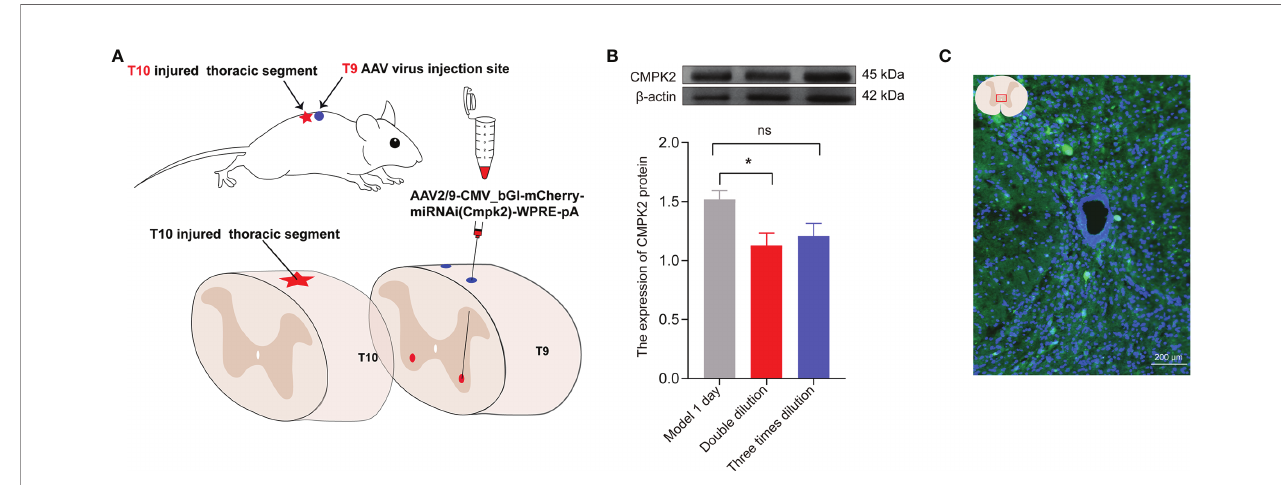
FIGURE 7 | The expression of CMPK2 around the central canal of the spinal cord was decreased after CMPK2 knockdown. (A) Schematic diagram of virus injection. (B) Quantitation of CMPK2 in the T10 spinal cord 4 weeks after virus injection using Western blotting. The results show CMPK2 protein expression after 2× and 3× viral dilutions. N = 3 rats/group. *p < 0.05 compared with the model group; one-way anOVA was used for comparison. (C) Fluorescent representation of CMPK2 expression in the T10 spinal cord 4 weeks after virus injection. All data are expressed as the mean ±